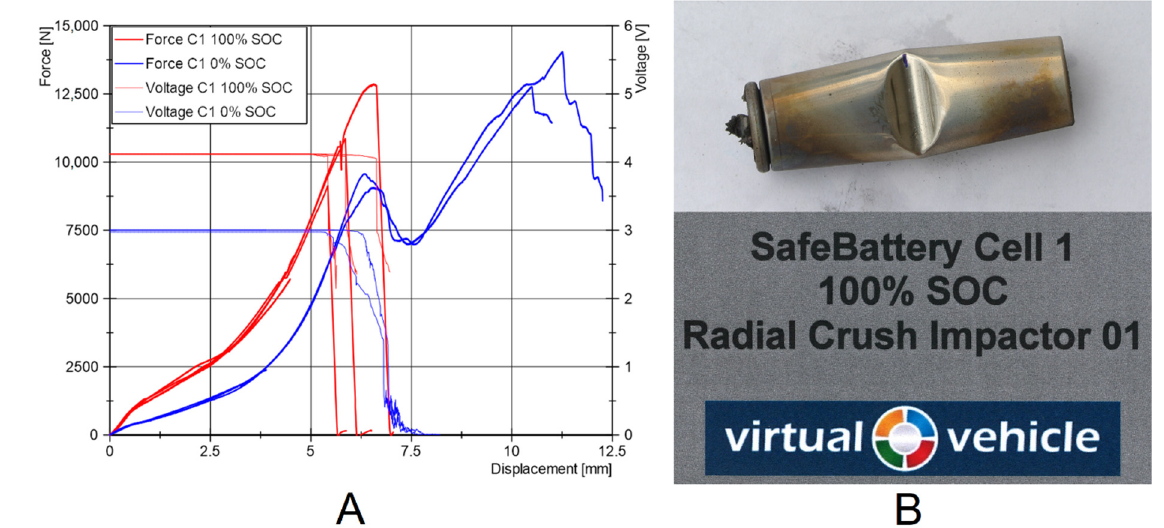
Figure 6. Radial crush impactor C1 (SOC comparison) force over displacement ( A ) and cell specimen after testing ( B ).